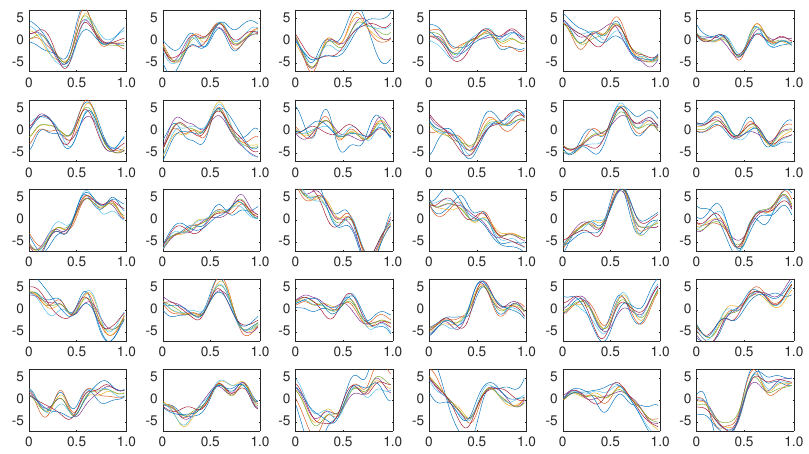
Figure 5. Coherently averaged signals segments of 1-second length containing the superimposed ERP. Vertical axis unit is µ V. Each one is extracted from the EEG signal of the Subject 1 of the pseudo-real dataset. These averaged signals correspond to the 15 first trials (2 averaged signals from each trial, one belonging to the column flashing and the other to row flashing). These are the templates used to build a dictionary per channel per subject and are used by the classification algorithm described in Section 3.6.5.